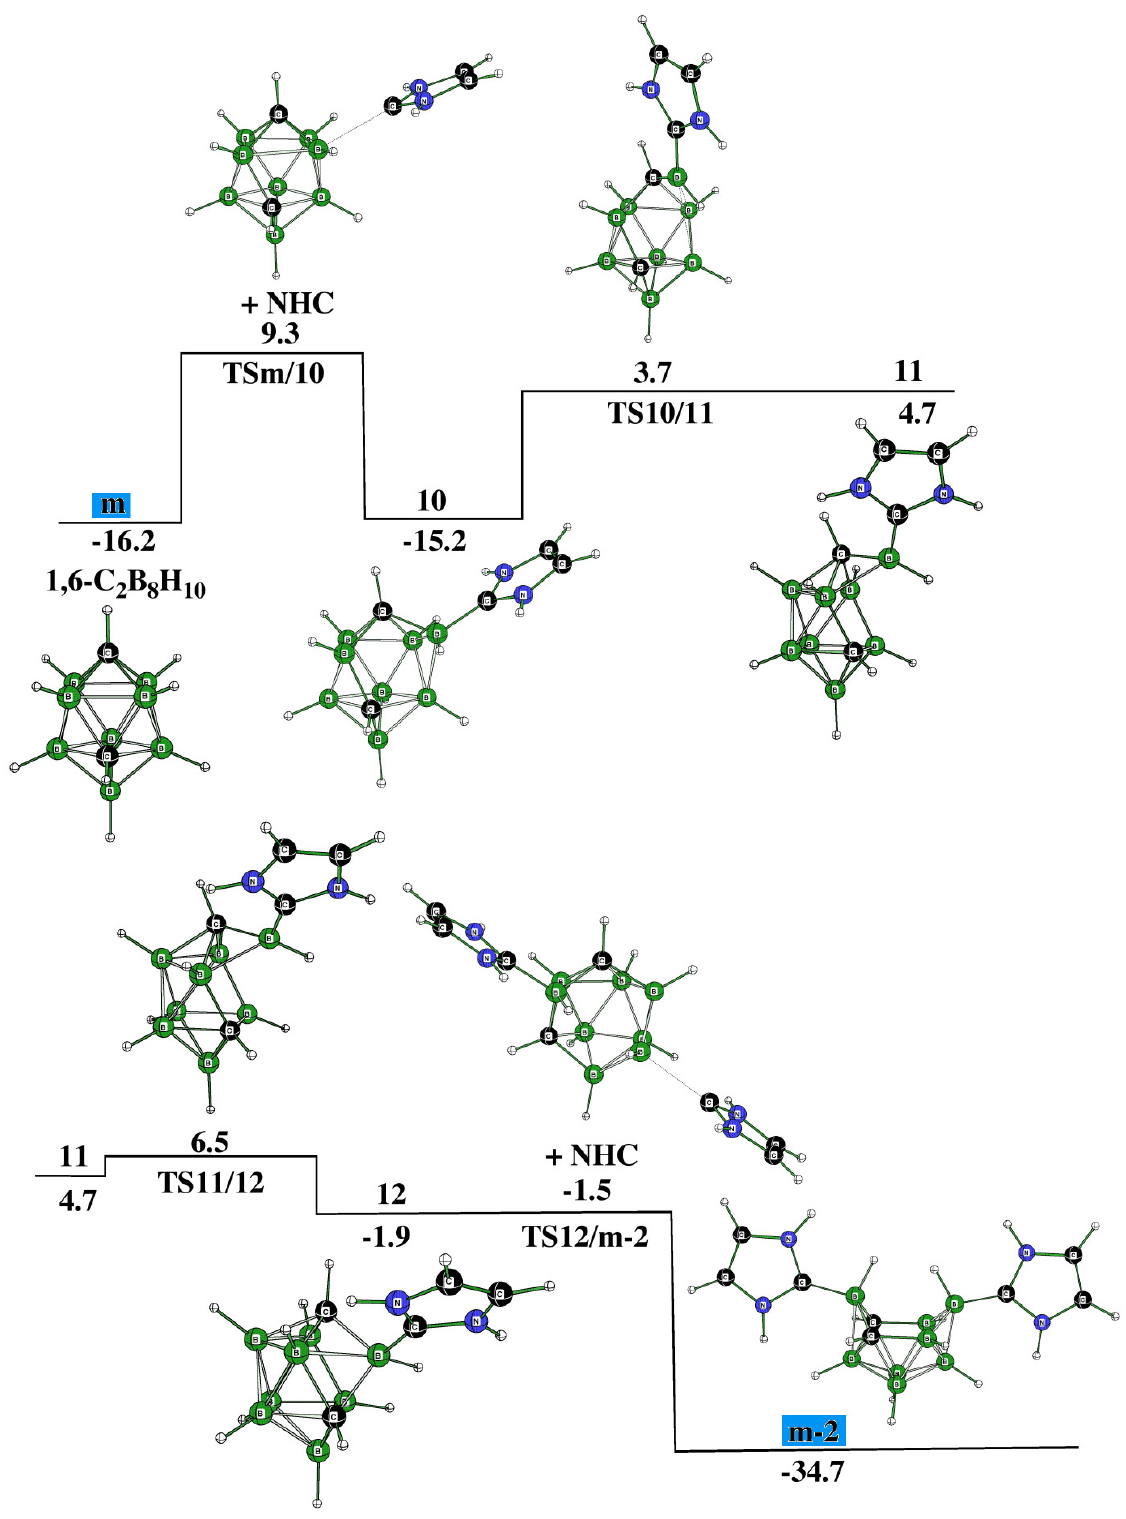
Figure 4. Relative free energies (kcal.mol − 1 ) of the individual stationary points on the potential energy surface (PES) of the formation of m ‐ 2 from m (see Tables 1 and S1 and Section 3 for details).